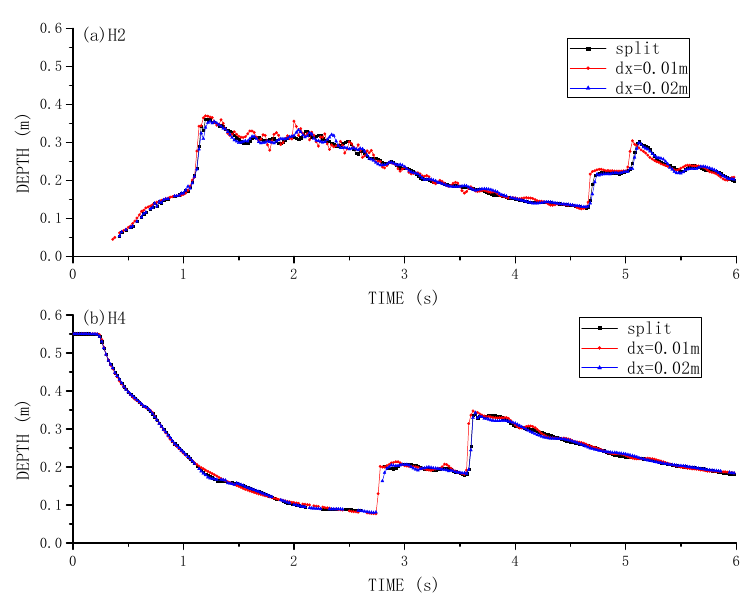
Figure 12. Time histories of dam break flow surface profile at gauging points computed by using particle refinement and splitting technique at: ( a ) H2; and ( b ) H4.